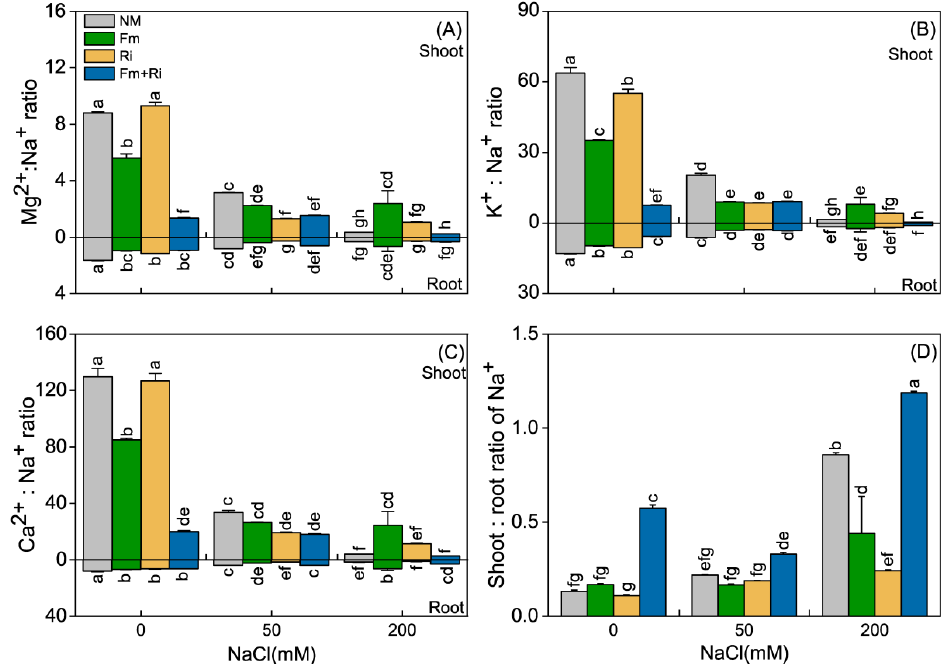
Figure 3. Effects of arbuscular mycorrhizal fungi on Mg 2+ :Na + ratio ( A ), K + :Na + ratio ( B ), Ca 2+ :Na + ratio ( C ) in shoots and roots, and shoot:root ratio of Na + ( D ) of Cinnamomum camphora plants under 0, 50, and 200 mM NaCl. NM, Fm, Ri, and Fm+Ri represent the four mycorrhizal treatments: inoculation with sterilized mycorrhizal fungi, with Funneliformis mosseae or Rhizophagus irregularis, either alone or in combination, respectively. Values are presented as the mean ± SE ( n = 3). Different lowercase letters indicate a significant difference for means of either root or shoot according to LSD at p < 0.05.